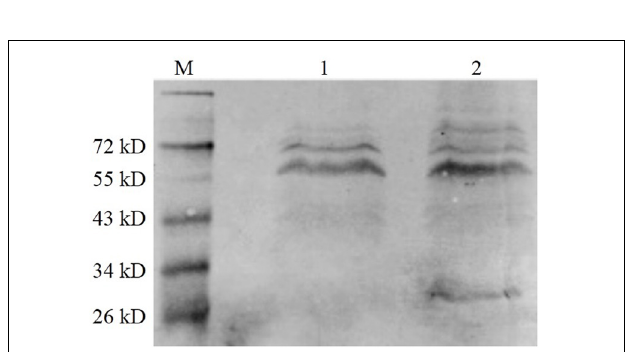
FIGURE 4 | Growth curve of bacteria in normal brain heart infusion (BHI) medium. EDGe was wild-type Listeria monocytogenes (LM). EDGeABdd was a mutant in which the act A, inl B, dal , and dat genes were deleted. EDGeABdd-t was constructed from EDGeABdd containing a pERL3-dat plasmid. EDGeABdd-t could survive in normal BHI without D -alanine.